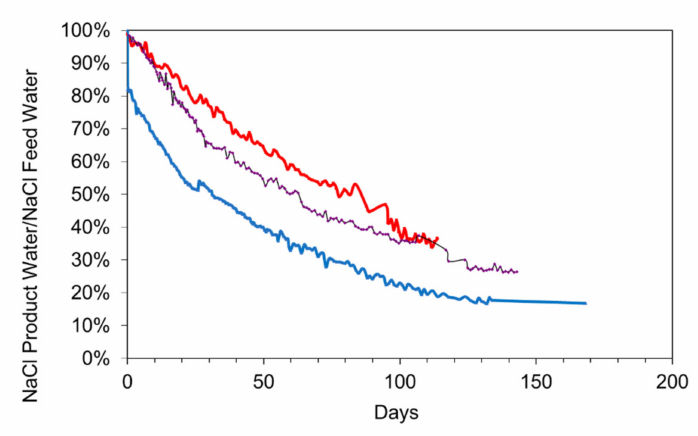
Figure 15. Comparison of three different materials for the desalination of static saline water: EC (electrical conductivity) = 15.2 mScm − 1 ; Salinity = 7.52 g L − 1 for the desalination pellet; EC (electrical conductivity) = 24.9 mScm − 1 ; Salinity = 13.44 g L − 1 for the n-Fe 0 ; Temperature = 0.2 to 14 ◦ C; water volume = 1 L). Red = Desalination pellet, 18 g L − 1 ; black = 1 g L − 1 n-Fe 0 ; Blue = 25 g L − 1 n-Fe 0 . The 25 g L − 1 n-Fe 0 displayed a 20% instantaneous desalination associated with the formation of Fe